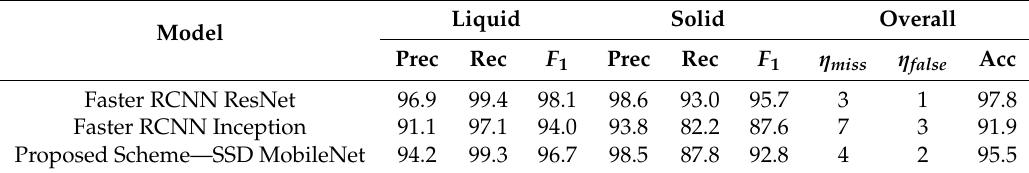
Table 3. Performance of different models for debris detection and classification.